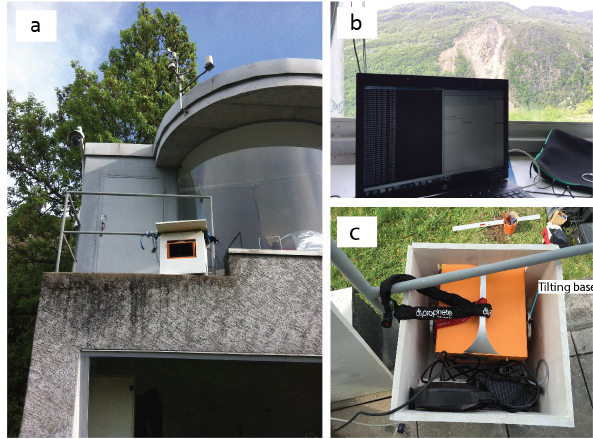
Figure 3. Setup of the ATLS monitoring system at the Cerema monitoring centre in Séchilienne, France, which consisted of (a) the TLS system and protective housing installed on the roof the centre; (b) a notebook installed inside the monitoring centre for near-real- time data processing and data visualization; and (c) TLS, tilting base and battery backup built within a protective housing.